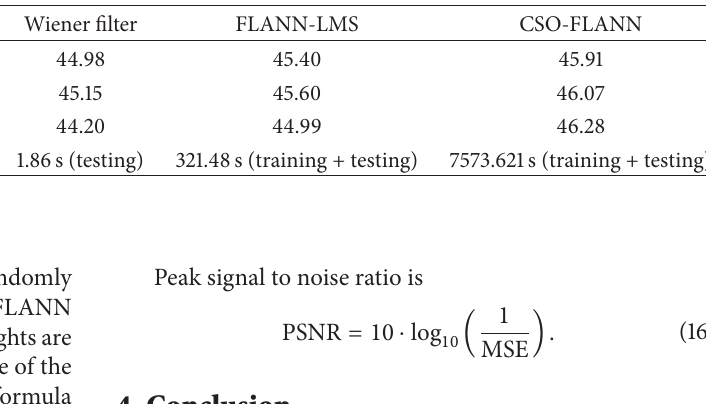
Table 1: Result for filters in terms of PSNR value in